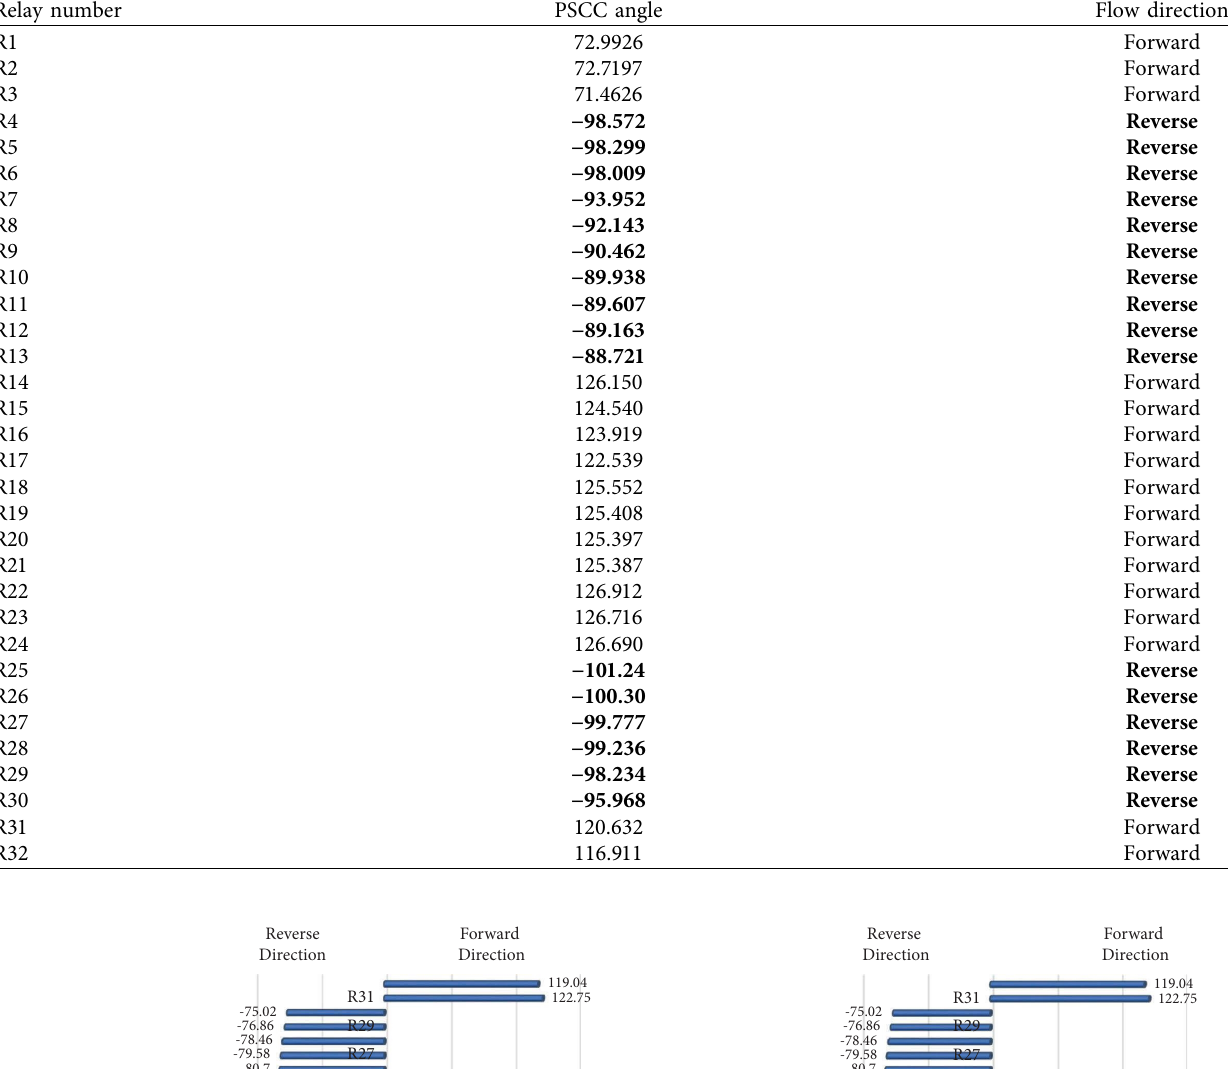
Table 5: Te PCSS angle for all relays at LG fault at S3 (case